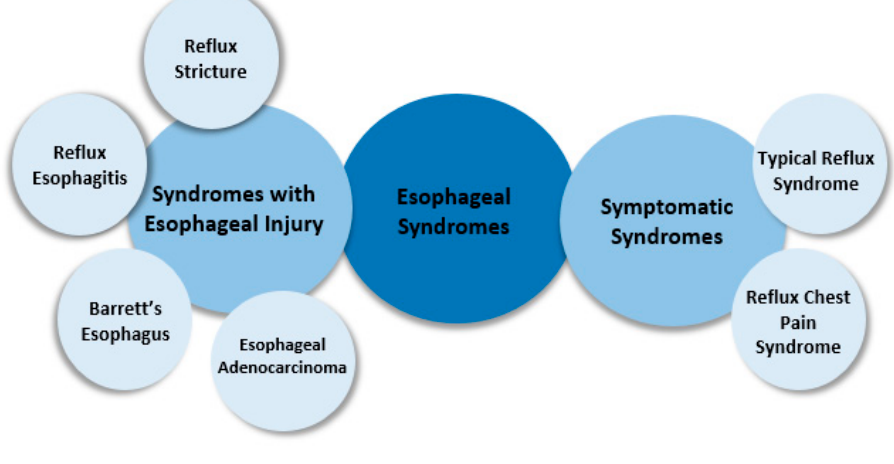
Figure 1. Esophageal syndromes of GERD [2].